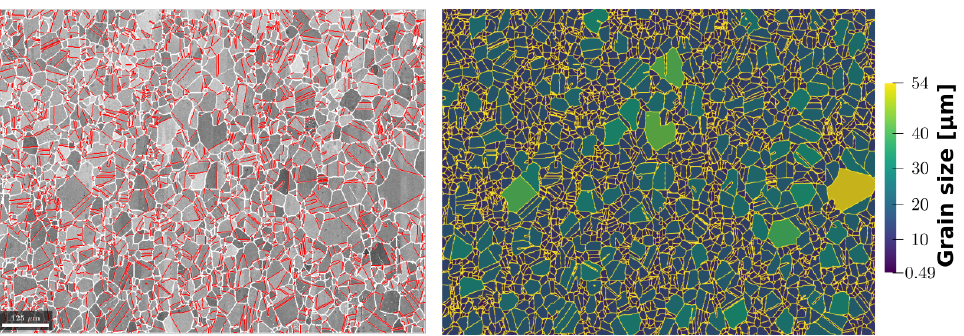
Figure 18. ( left ) EBSD band contrast map with GBs depicted in white and Σ 3 TBs colored in red, and ( right ) its numerical microstructure displayed with a color code related to the grain size and GBs are colored in yellow. Here, TBs are considered to calculate grain size, i.e., crystallite size.